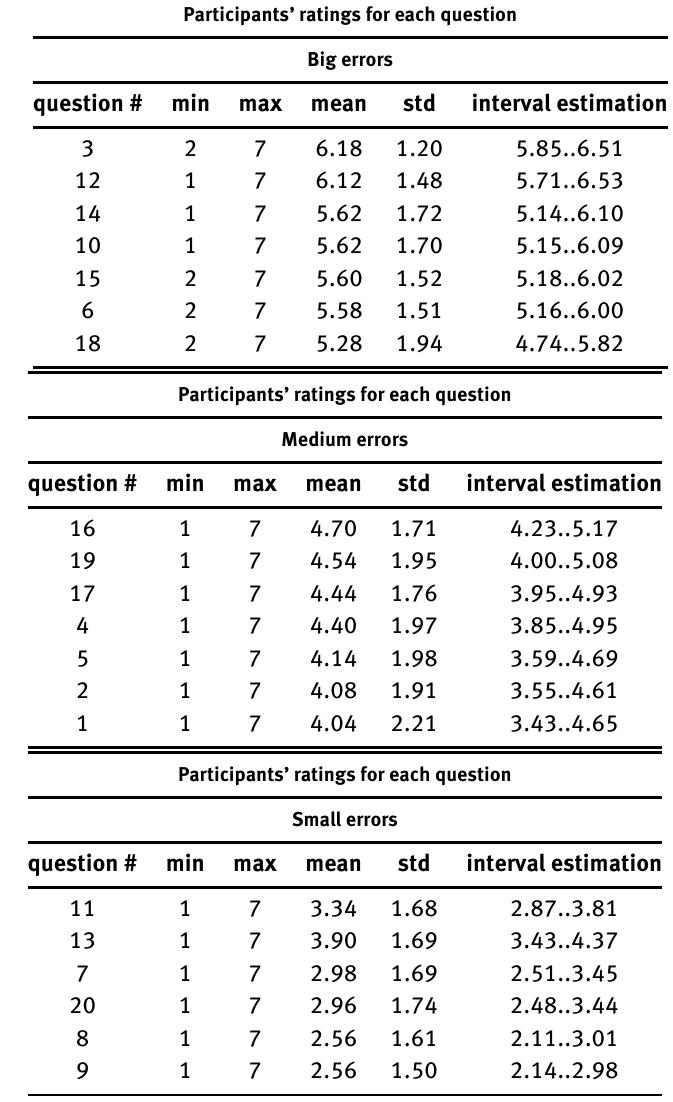
Table 1: Participants’ responses to the 20 different scenarios were ranked according to their mean perceptions of the magnitude of the errors. The ’Big Errors’ category groups all the errors rated with mean value greater than 4; the ’Small Errors’ category groups all the errors rated with mean values smaller than 4; the ’Medium Errors’ category groups all the other errors (i.e. those rated as